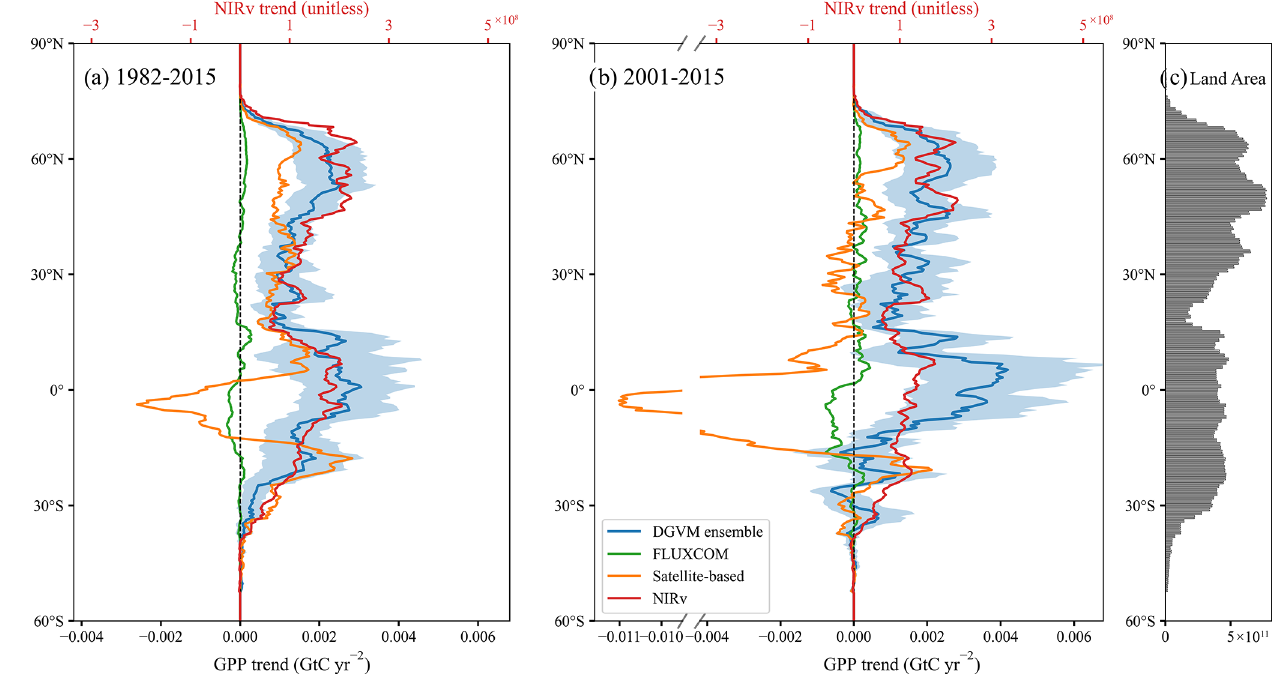
Figure 2. Latitudinal profiles of trends of annual zonal total NIRv and GPP (0.5 ◦ latitudinal bins). Results for the DGVM ensemble mean (blue), FLUXCOM GPP (green), satellite-based products (orange), and NIRv (red) during 1982–2015 (a) and 2001–2015 (b) , respectively. The GPP values are given on the bottom axis and the NIRv values on the top axis. The shaded areas represent the standard deviation of the individual TRENDY model-simulated GPP trend. The units of the NIRv and GPP trends are unitless and GtCyr − 2 , respectively. Panel (c) represents the latitudinal total vegetated land areas (m 2